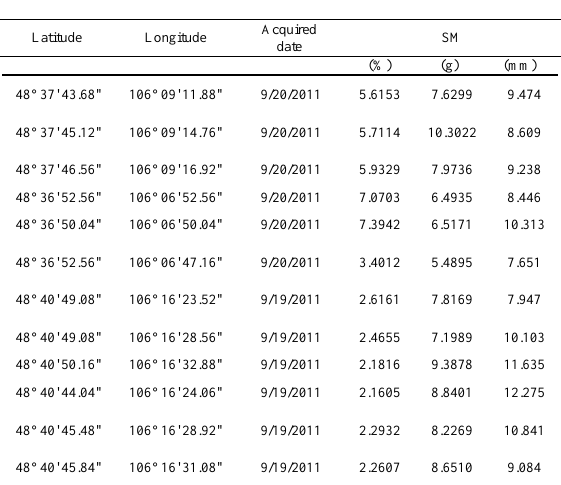
Table 1. Ground truth measurement in Bornuur soum, 18~20 Sept. 2011